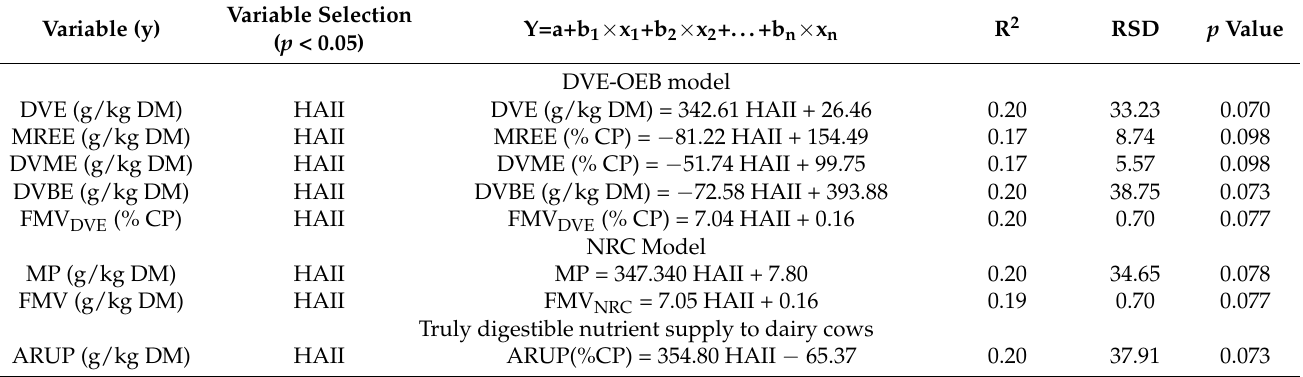
Table 4. Multiple Regression Analysis to Study Association between Protein Spectral Parameters and Truly Absorbed Protein, Intestinal Protein Degradation, Rumen Degradation Parameters of Cool-Season Adapted CDC Chickpeas.